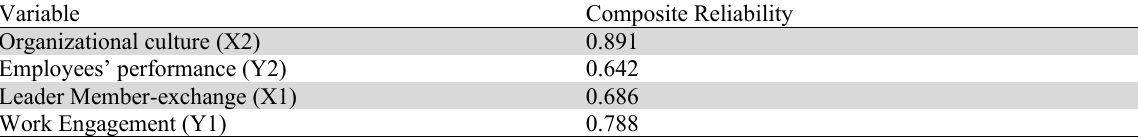
The Cronbach’s Alpha results of each valuable Variable